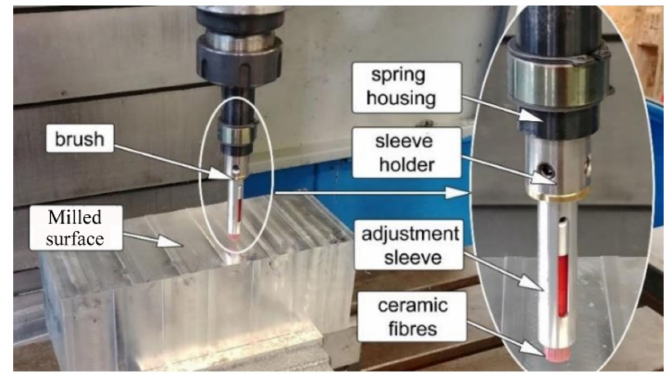
Figure 1. Lapping experiment in CNC machine